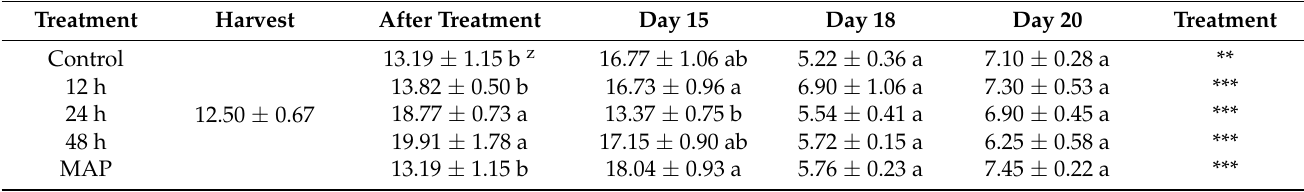
z Values are represented as the mean ± SE ( n = 4), and different alphabets within columns represent significant differences among treatments for each measuring day using Tukey’s multiple comparison test. Day 18 and Day 20 represent three and five days after cold storage, respectively. **, ***: significant at p ≤ 0.01 and